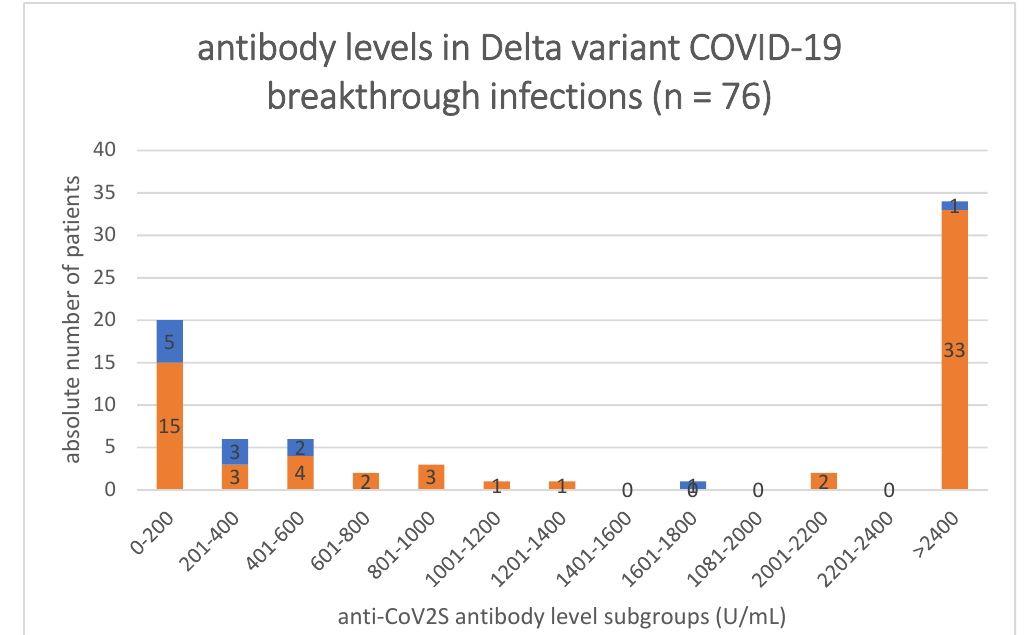
Figure 1. Subgroupanalysis of the anti-CoV2S antibody level in U/mL. Antibody levels were available in 76 of the 80 patients in this cohort. The anti-CoV2S antibody level is depicted in a range of 200 U/mL. The blue bars show the absolute number of deceased patients (n = 12). The orange bars show the absolute number of all patients with the respective level subgroups who survived (n = 64).